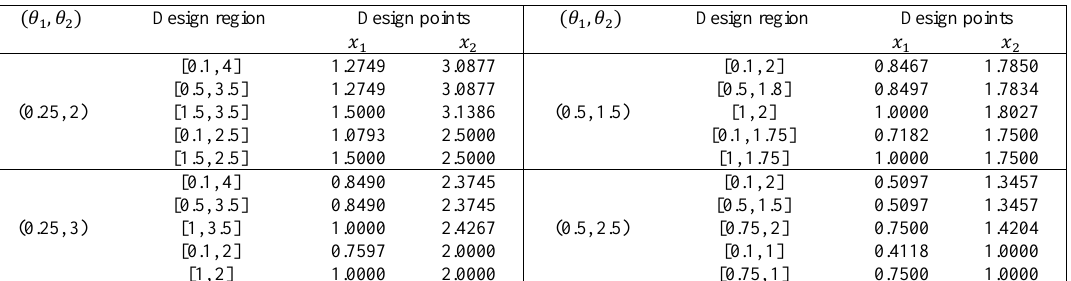
𝑤 = 0.5, 𝑤 = 0.5 1 2